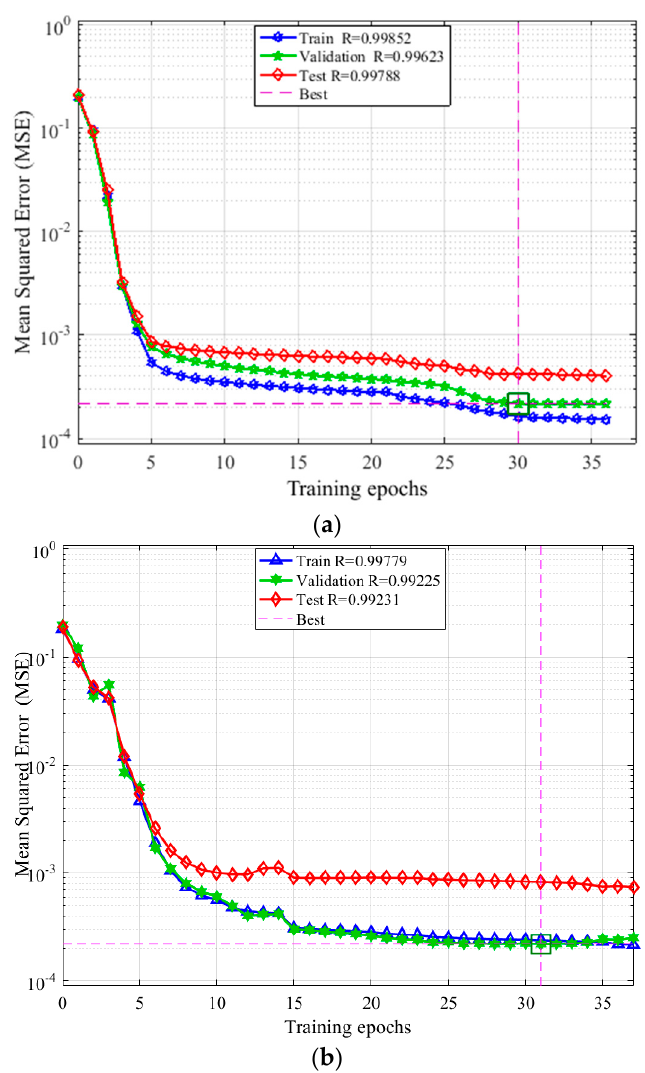
Figure 8. The training results of the 9-2-12-3 IANN model ( a ) and the 7-2-10-3 OANN model ( b ). Table 9. The weights of the established model.